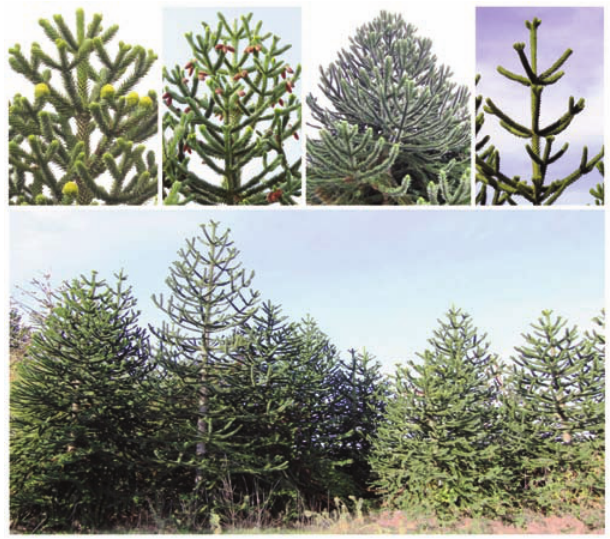
Fig. 8 - Habitus variability in Araucaria araucana trees grown in Pistoia’s hinterland in a plain